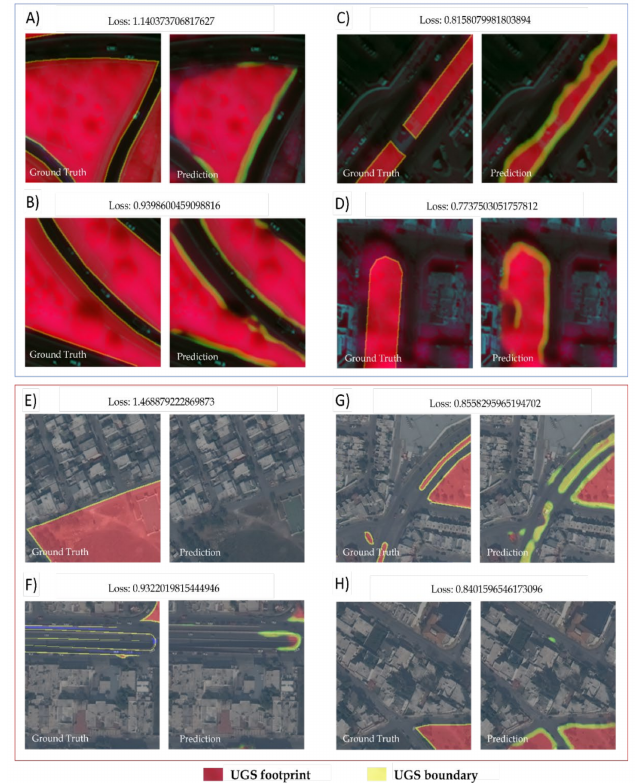
Figure 8. Progression of the segmentation process of UGSs for both encoders. ( A – D ) Samples obtained using an NDVI–red–NIR composition from ResNet34 encoder. ( E – H ) Samples obtained using a red–green–blue composition from ResNet50 encoder. The information is presented at the same scale; each square surface is 1.63 hectares (ha).